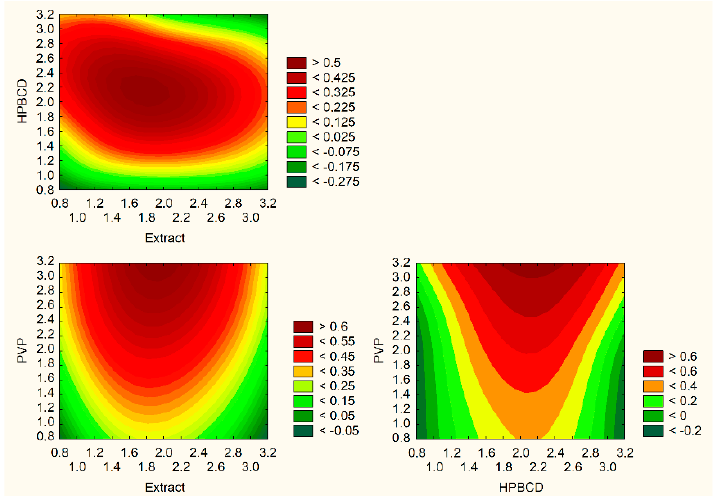
Figure 6. Model utility contour profiles for all effects for electrospun nanofibers optimalization.